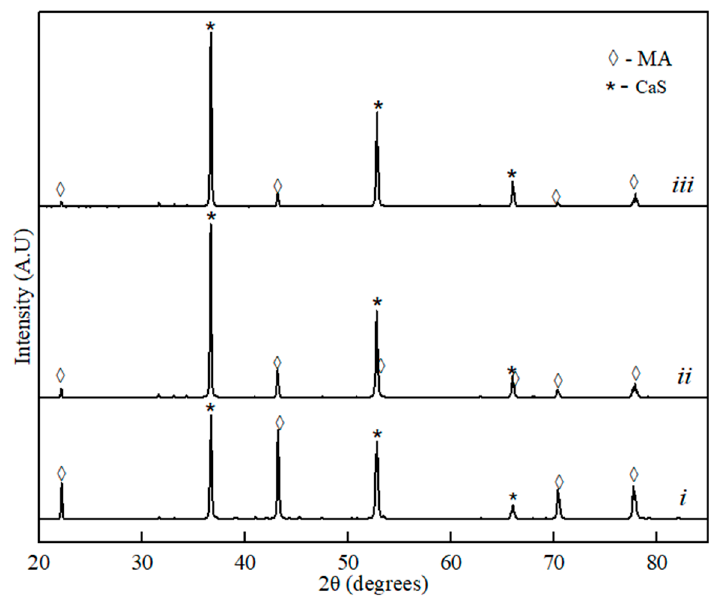
Figure 1. XRD spectra for the binary sample of MgO·Al 2 O 3 (MA)–CaS: ( i ) 20% of CaS, ( ii ) 60% of CaS, and ( iii ) 80% of the CaS phase component.